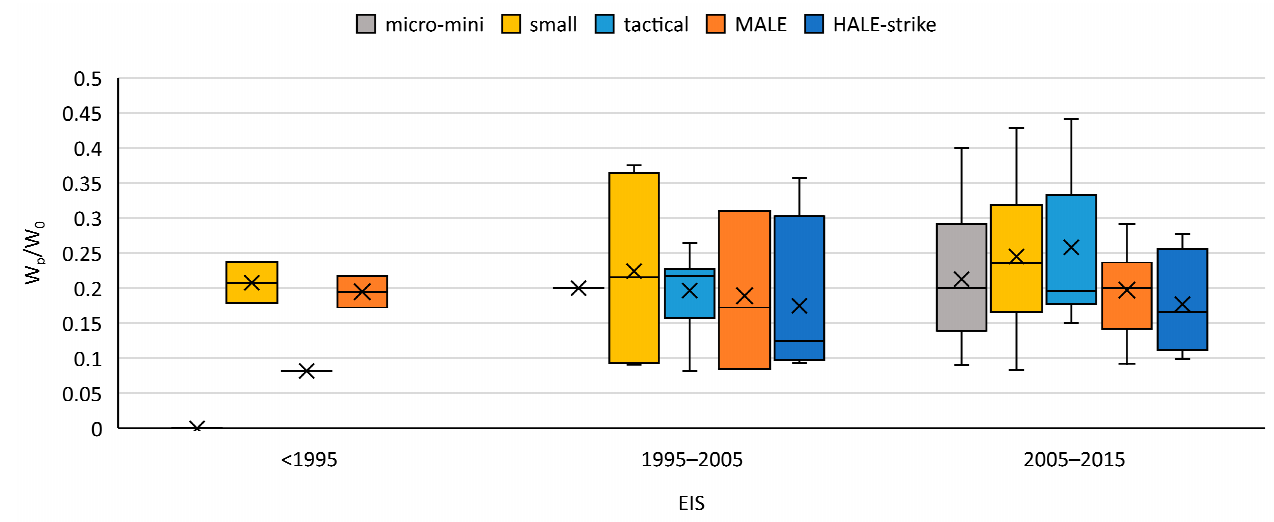
Figure 24. Payload weight over GTOW ratio EIS progression per NATO category.